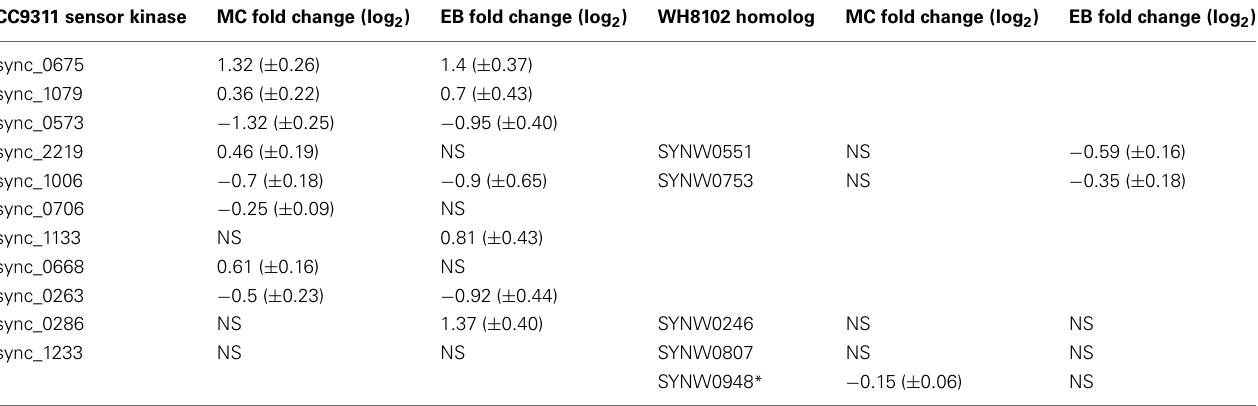
Table 3 | Transcriptional response of sensor kinases to toxic shock treatments in Synechococcus sp. CC9311 and WH8102. CC9311 sensor